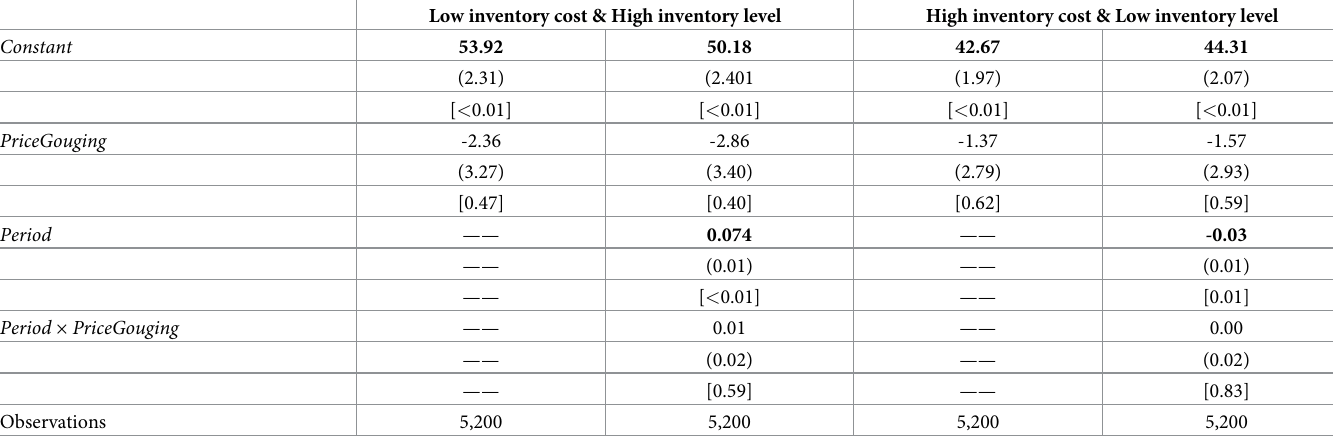
Table 4. Analysis of difference between newsvending and price gouging